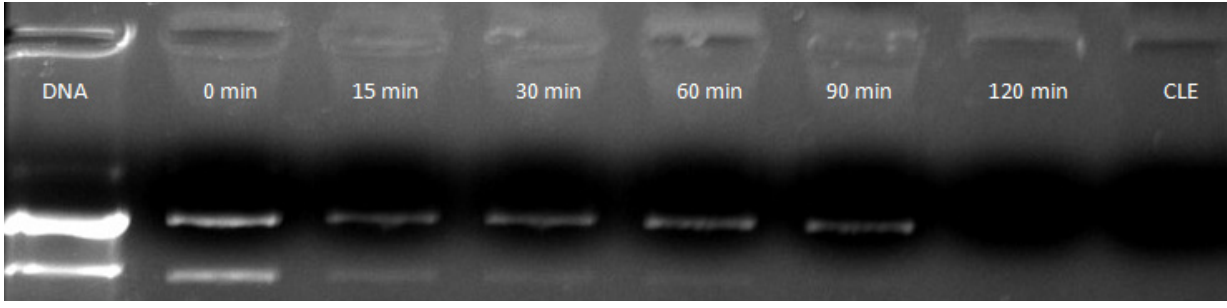
Figure 3. Time complexation of pDNA by CLN